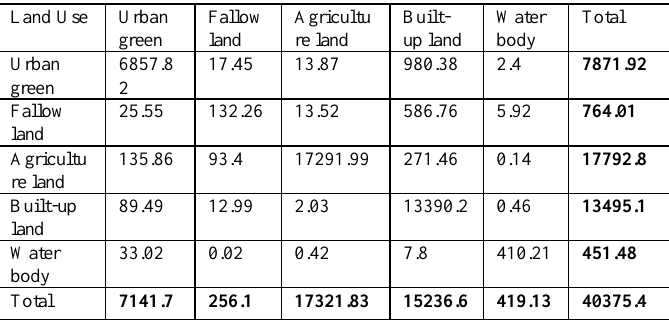
Table 4: Land Use/Land Cover change area during 2008-2015 in